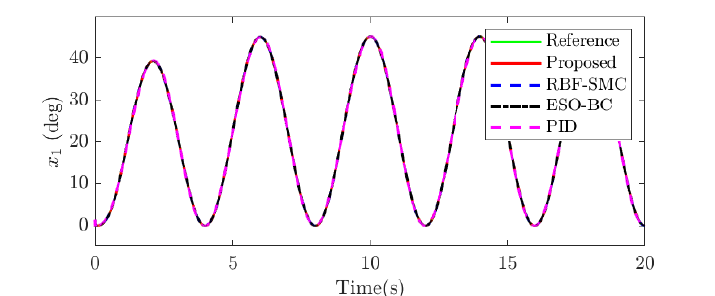
Figure 3. The tracking performance of the proposed strategy compared with other control laws with slow-motion reference trajectory.